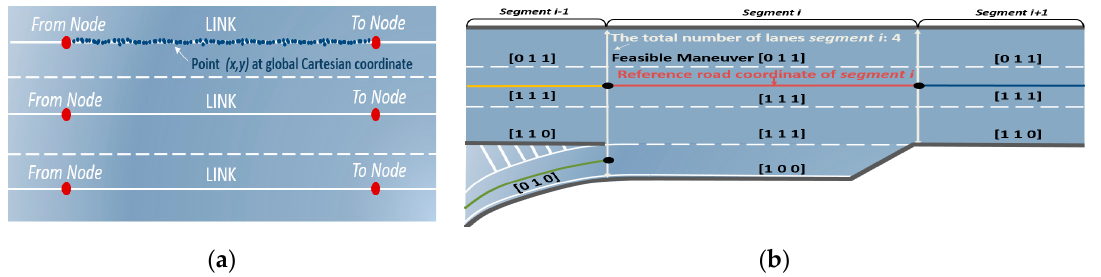
Figure 3. Extraction of road information. ( a ) HD maps contain nodes and links and each component is represented by points in the Cartesian coordinate system; ( b ) After extracting information via offline preprocessing, each segment has information corresponding to the segments such as B-spline parameters, lane information, length of the segment, and a feasible maneuver one-hot vector.